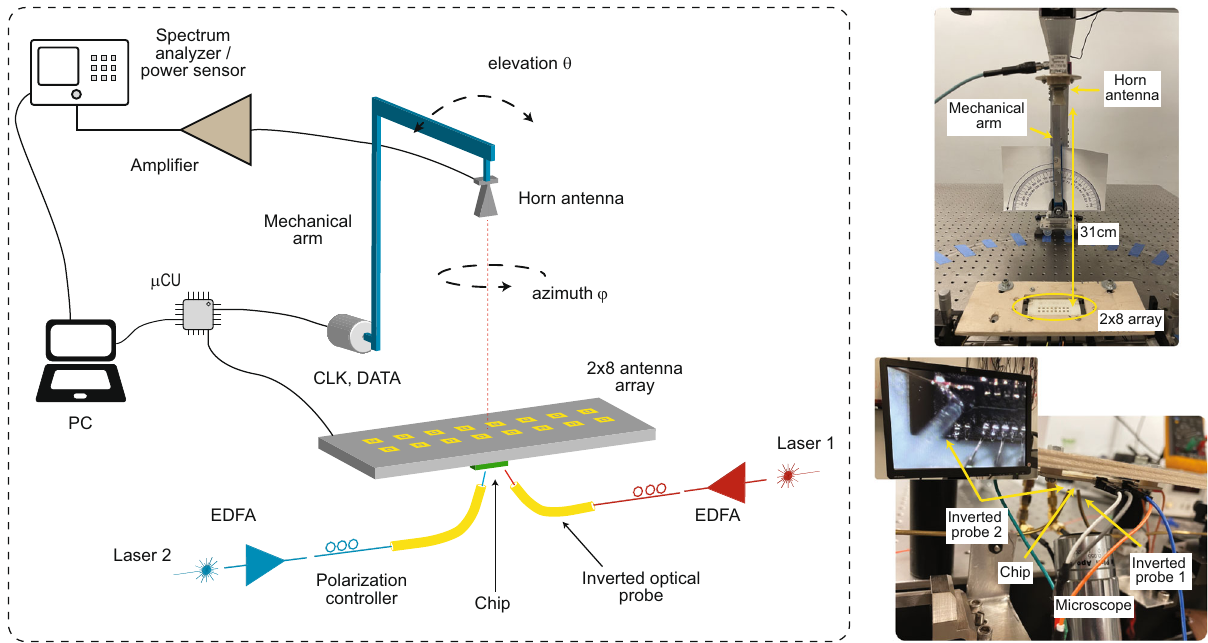
Fig. 4 | Beam formation and radiation pattern measurement setup. Measure- ment setup used to calibrate the phased array and measure the radiation pattern whensteered to differentangles.The steering angleis set by programming the